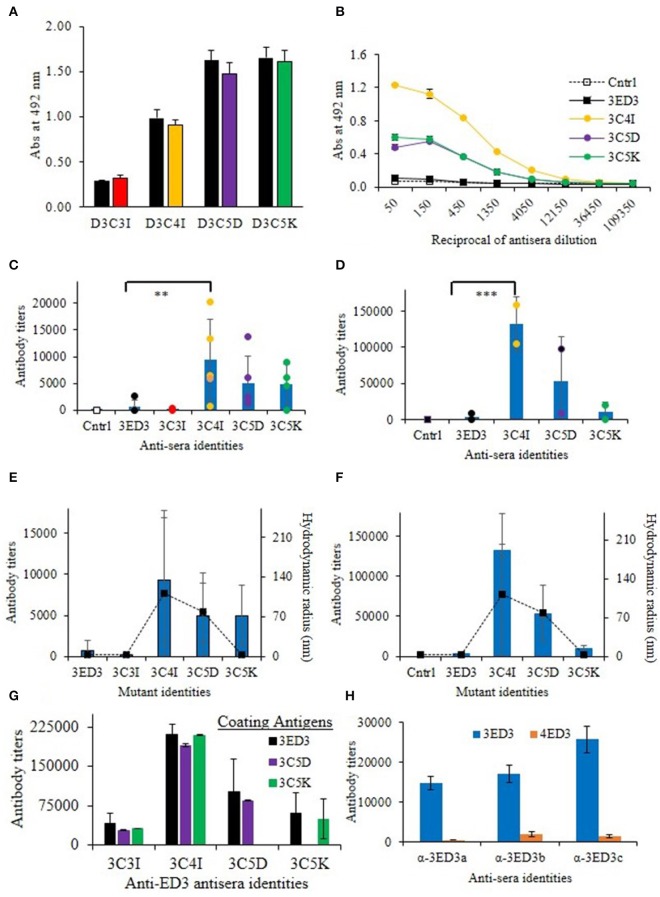
Immunogenicity of 3ED3 and its SCP-tagged variants. (A) Anti-3ED3 specificity of antisera generated against 3ED3 and its SCP-tagged variants assessed by ELISA. OD492nm at 1:50-fold antisera dilution is shown (black: against 3ED3; red: against 3C3I; orange: against 3C4I; violet: against 3C5D; green: against 3C5K as coating antigen). (B) Absorbance at 492 nm vs. the reciprocal of antisera dilution against 3ED3 (legends are given in the panel). (C) IgG antibody titer after the fourth dose in the absence of the adjuvant [n = 2 (PBS), 9 (D3wt), 2 (D3C3I), 5 (D3C4I), 5 (D3C5D), 4 (D3C5K); **P < 0.05, ***P < 0.001 (Dunnett's test) (29)]. (D) IgG antibody titers after the fourth dose in the presence of the adjuvant. Immunization experiments were carried out in the Jcl:ICR (CLEA, Japan) mice model. Bars represent averaged antibody titer, and scattered points stand for individual mice data [color codes are as in (B)]. Correlation between the antibody titers (bars on the primary axis) and the aggregates' hydrodynamic radii at 37°C in the absence of the adjuvant (E) and in the presence of the adjuvant (F). Scattered points along the secondary axis stand for hydrodynamic radii. (G) Antibody titers determined against untagged (3ED3) and its SCP-tagged (C5D and C5K) variants. (H) ELISA data for anti-3ED3s sera against 3ED3 and 4ED3. All anti-3ED3 sera showed sero-specific recognition 3ED3 and no cross-recognition of 4ED3, confirming that all antibodies were serotype specific.